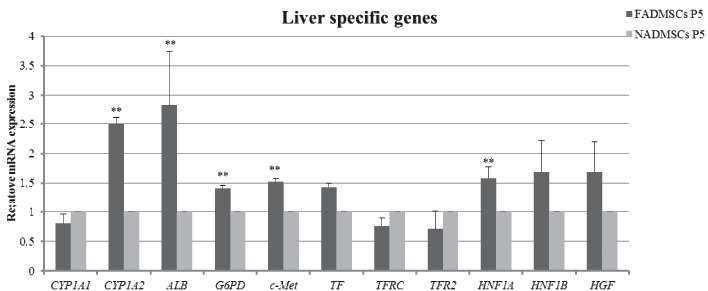
Figure 7. Real-Time Quantitative-PCR (RT-QPCR) analysis of liver-specific gene expression in ALF-derived ADMSCs and normal ADMSCs. The relative expression levels in normal ADMSCs were normalized to 1. Mean ± SD values are plotted. ** p < 0.01.